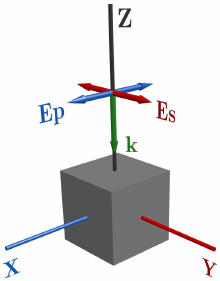
Figure 1. Diagram of a nanocube. It is illuminated by a monochromatic plane wave propagating ( (cid:126) k ) along the z -axis with either P- or